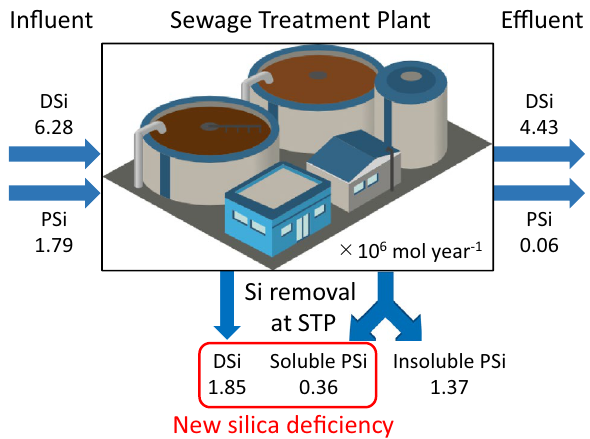
Figure 2. Si cycling model in an STP. Each line shows the Si amount of STP influent, effluent, and removal, respectively. The reduction of DSi and soluble PSi by the STP creates a new silica deficiency hypothesis (the illustration was created by the image library, free material provided by the Integration and Application Network, University of Maryland Center for Environmental Science